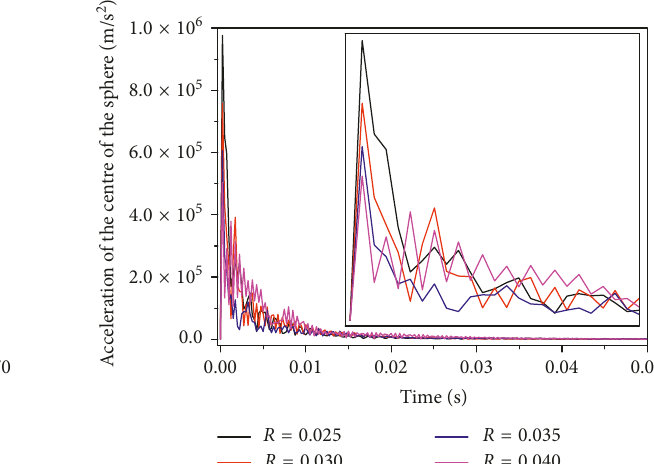
Figure 33: Velocity of the tail beam.